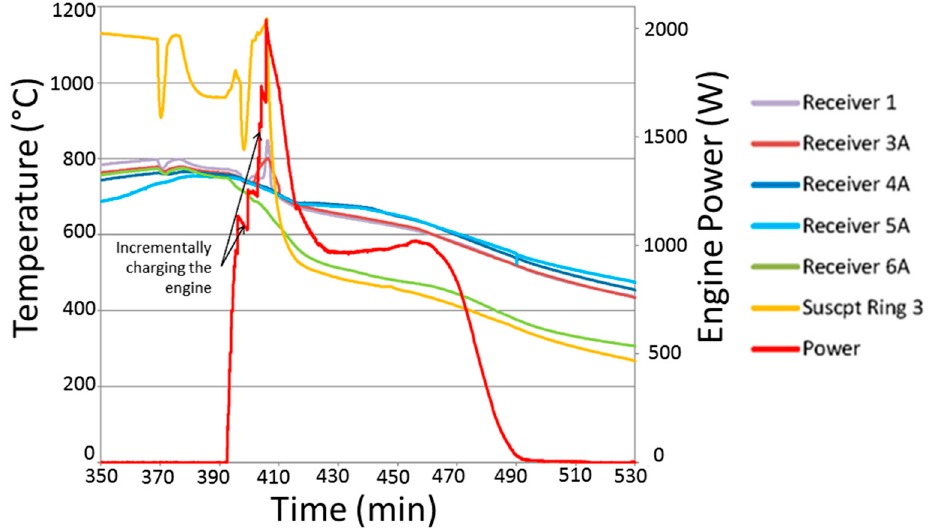
Figure 13. Temperatures during discharging in the horizontal orientation.